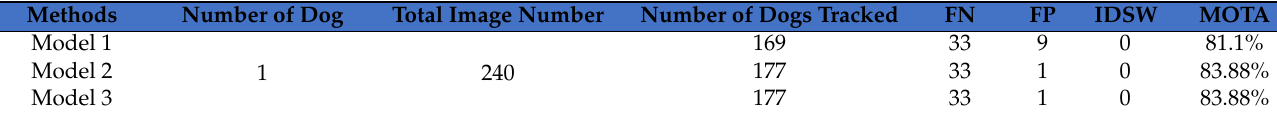
Table 12. Results of dog tracking experiments conducted using IMG_0043_5 data-set.